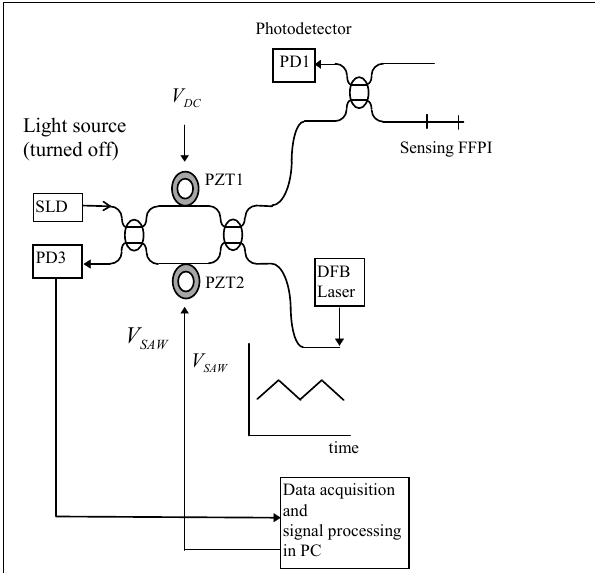
Figure 9. Configuration of set-up to measure non-linearity of scanning